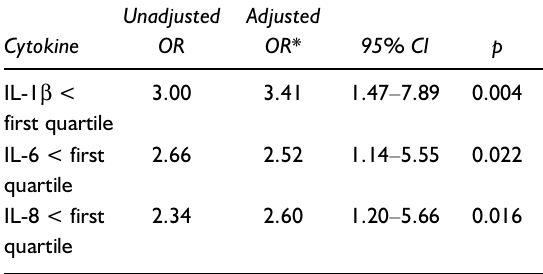
Table 1 Statistical analysis of the